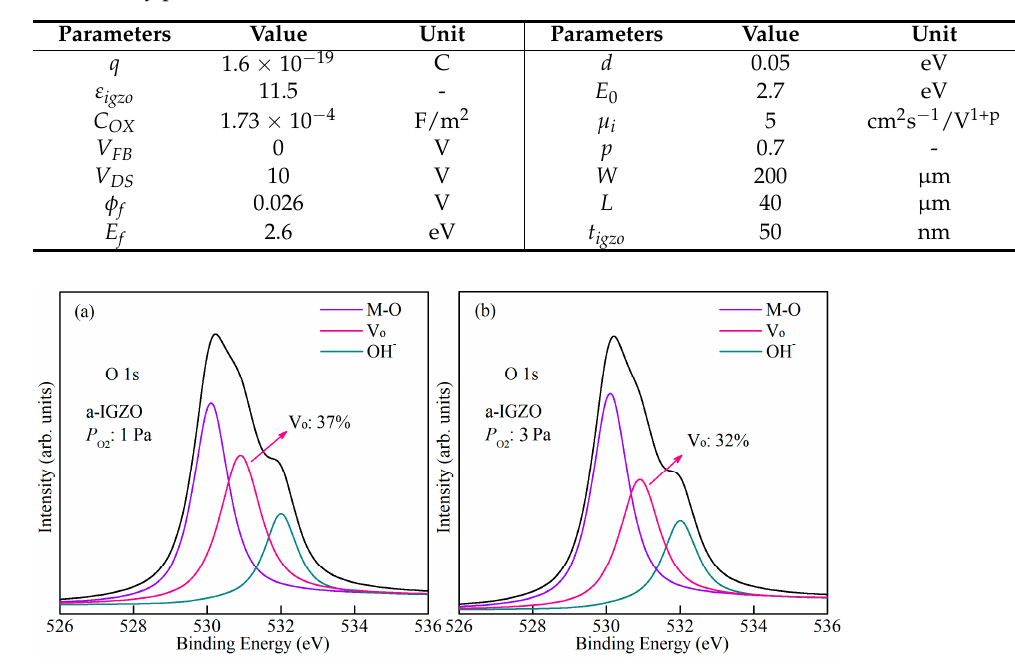
Figure 2. Comparison of the surface potential solution with the numerical result for ( a ) different values of V ch and ( b ) various DOS distributions. Table 1. Key parameters used in the model.